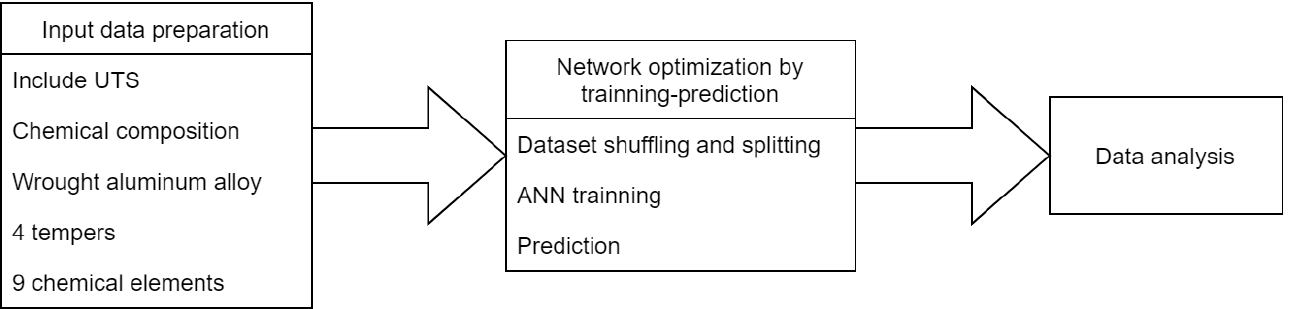
Figure 1. Overview of the